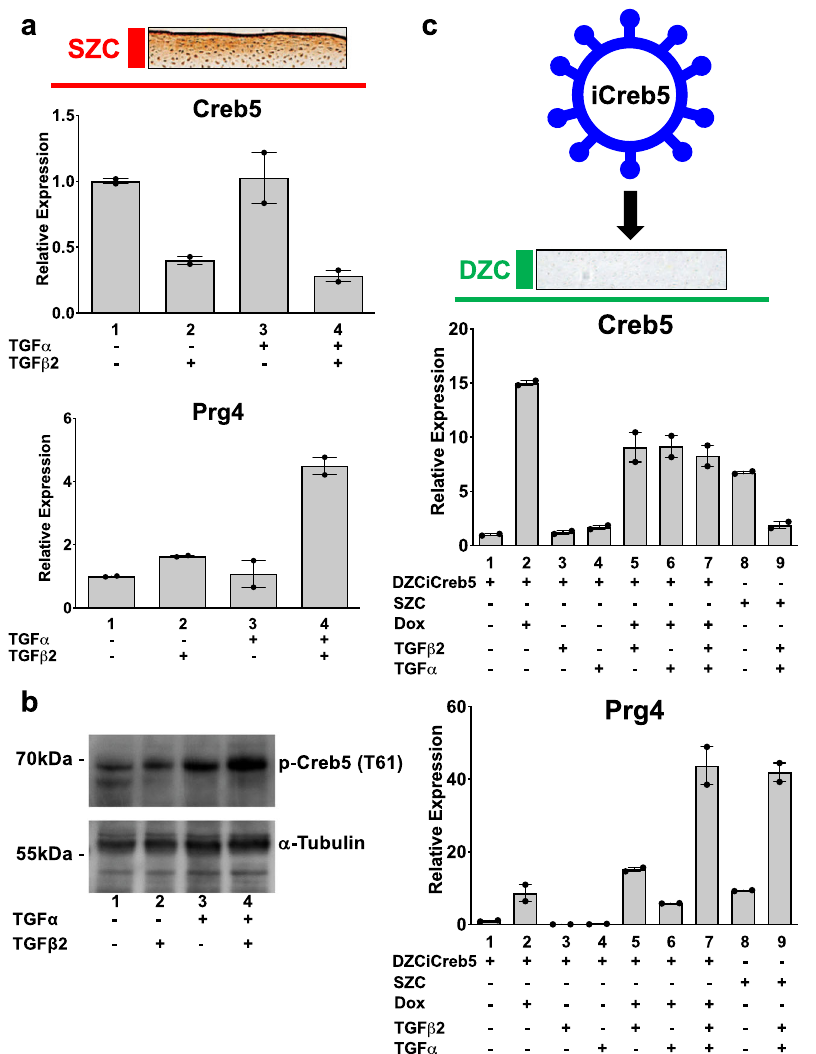
Fig. 4 Forced expression of Creb5 in deep zone articular chondrocytes confers competence for EGFR and TGF- β signals to induce expression of Prg4 . a , b EGFR and TGF- β signals synergistically induce expression of Prg4 in SZCs. SZCs were treated for 2 days with TGF- β 2 (20 ng/ml) and TGF- α (100 ng/ml), as indicated. a Gene expression was assayed by RT-qPCR and normalized to Gapdh . Error bar indicates standard error of the mean ( n = 2 technical repeats). Similar results have been obtained in three independent biological repeats. b Western analysis of proteins in SZCs cultured in either the absence or presence of TGF- β 2 (20 ng/ml) and TGF- α (100 ng/ml). Similar results have been obtained in two independent biological repeats. c Forced expression of Creb5 in DZCs promotes synergistic induction of Prg4 by TGF- α and TGF- β 2. DZCs were infected with a lentivirus encoding doxycycline- inducible Creb5. After selection in G418, the cells were cultured in either the absence or presence of doxycycline (1 μ g/ml), TGF- β 2 (20 ng/ml) and TGF- α (100 ng/ml), as indicated for 3 days. Gene expression was assayed in both the iCreb5-DZCs (lanes 1 – 7) and in control SZCs (lanes 8 and 9) by RT-qPCR and normalized to Gapdh . Error bar indicates standard error of the mean ( n = 2 technical repeats). Similar results have been obtained in three independent biological